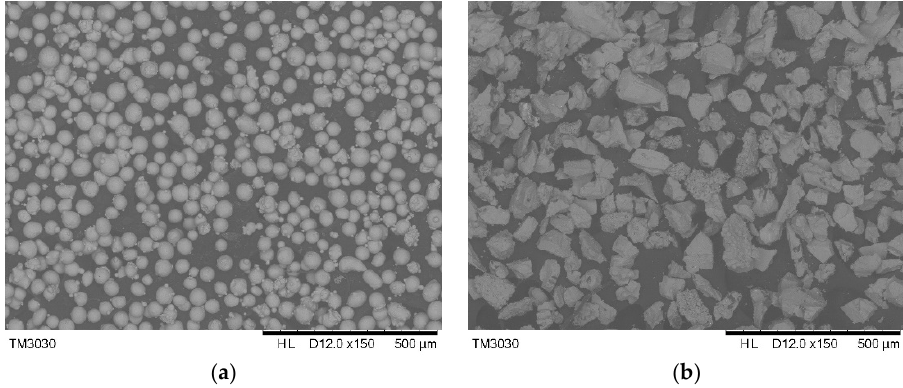
Figure 1. ( a ) Morphology of 316L powder; ( b ) Morphology of TiC powder.